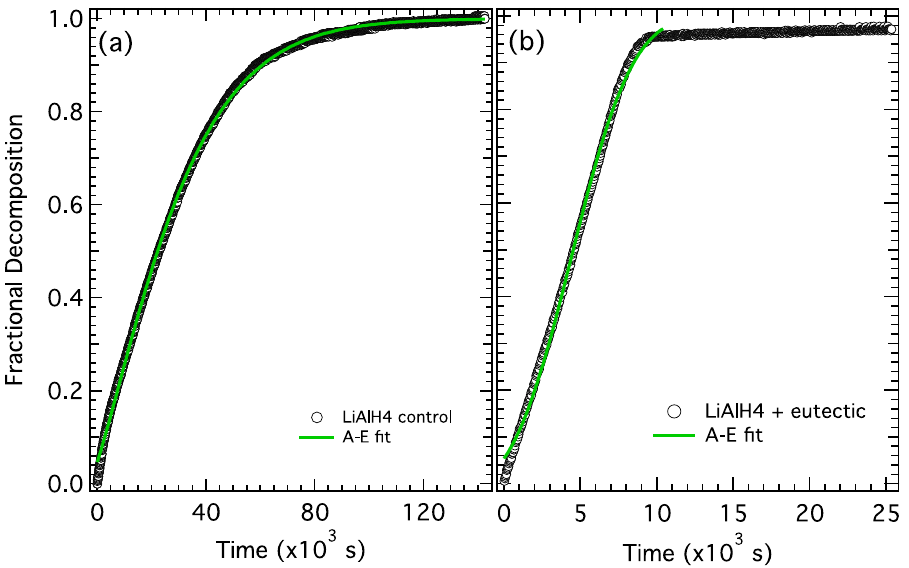
Figure 7. Fractional decomposition from step 2 for ( a ) LiAlH 4 control and ( b ) LiAlH 4 + Li-KBH 4 eutectic. Table 4. Fit parameters from an A-E fit to the second step of desorption (fractional decomposition) of LiAlH 4 (control) and LiAlH 4 + diglyme.